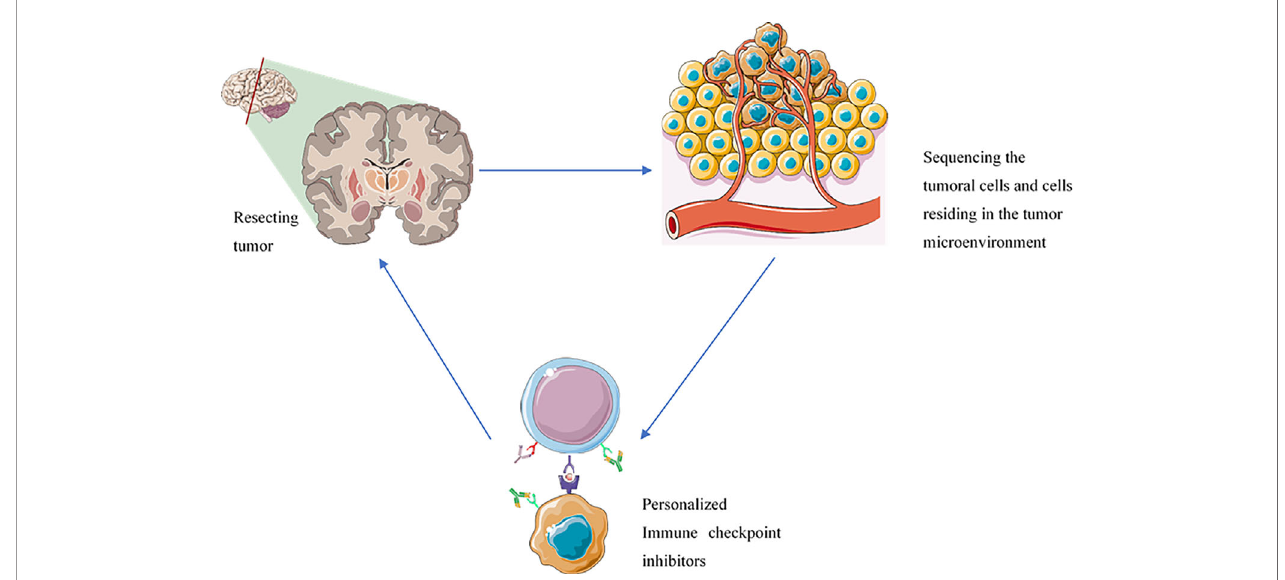
FIGURE 2 | The administration of immune checkpoint inhibitors based on the inhibitory immune checkpoint expression pro fi le of each patient can improve patients ’ response rates, decrease the risk of immune-related adverse events development, prevent the immune-resistance development, and reduce the risk of tumor recurrence. The components of this fi gure were obtained from